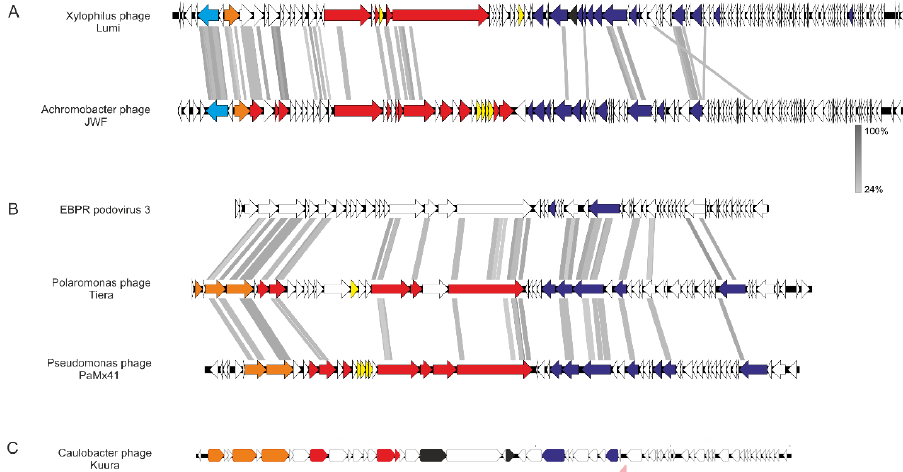
Figure 5. Genome organizations of ( A ) Lumi, ( B ) Tiera, and ( C ) Kuura phages and their related phages. In ( A ), Xylophilus phage Lumi (80,496 bp in length) and Achromobacter phage JWF (81,541 bp). Both have 118 predicted open reading frames (ORFs). In ( B ), the genomes of Polaromonas phage Tiera (45,327 bp) in the middle and related EBPR podovirus 3 on top (a partial sequence, 38,991 bp, assembled from metagenome) and Pseudomonas phage PaMx41 (43,490 bp) in the bottom. In ( C ), the genomic organization of Caulobacter phage Kuura (43,813 bp), which is unique. Putative functional genes are color-coded: Light blue corresponds to primpol, orange packaging, red structural, yellow genes related to host lysis, black transglycosylases, blue replication, and pink repressor. White denotes hypothetical protein. Functions defined in other phages [32–34] were used as references. Alignments were created with Easyfig [22] employing Blastx. Grey areas between the genomes indicate detected amino acid identity; the level is indicated with a gradient scale in between ( A ) and ( B